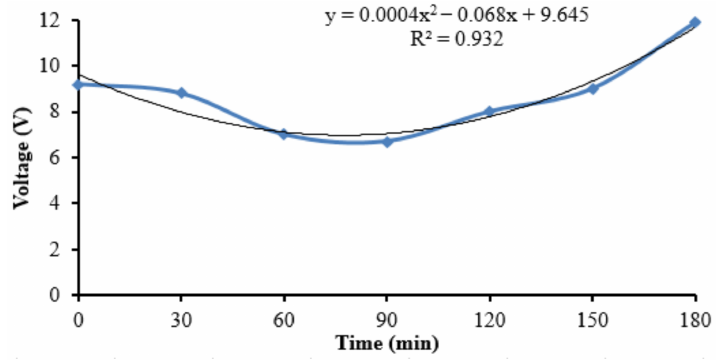
Figure 11. Changing the voltage on the cell.